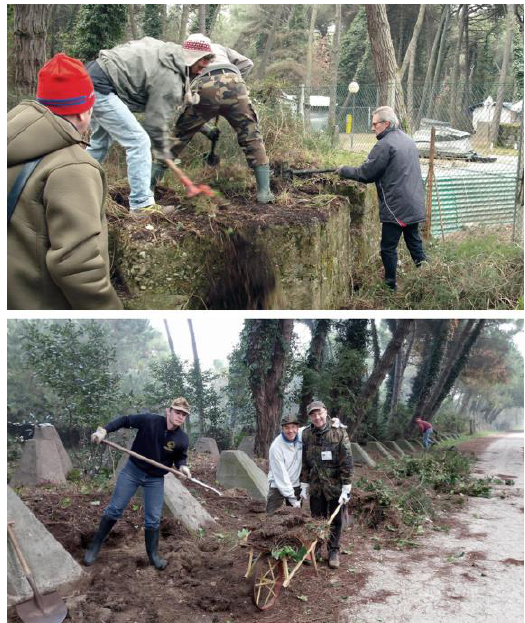
Figure 7. Local community at work. © CRB360°,